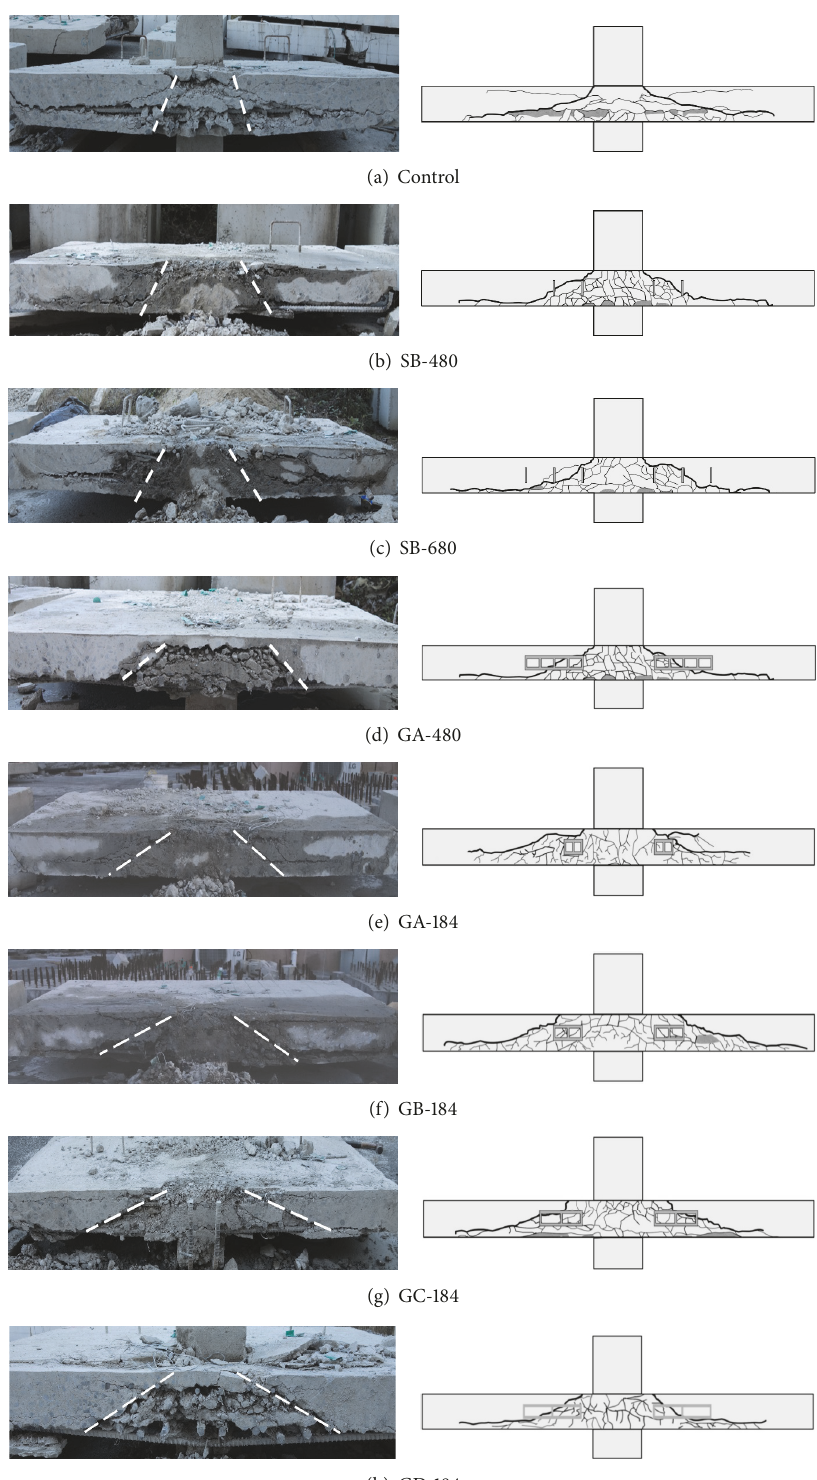
Figure 9: Cracking patterns in the saw-cut slab cross sections of each